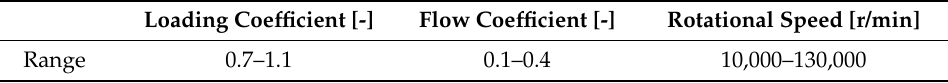
Table 2. Range of design space.